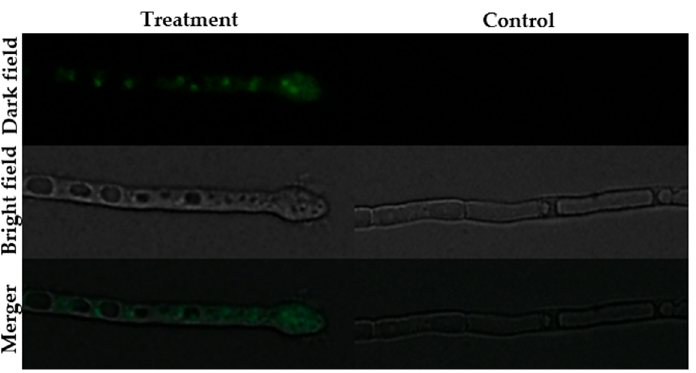
Figure 5. Permeabilization of Mycosphaerella arachidicola hyphal membrane caused by BGAP.